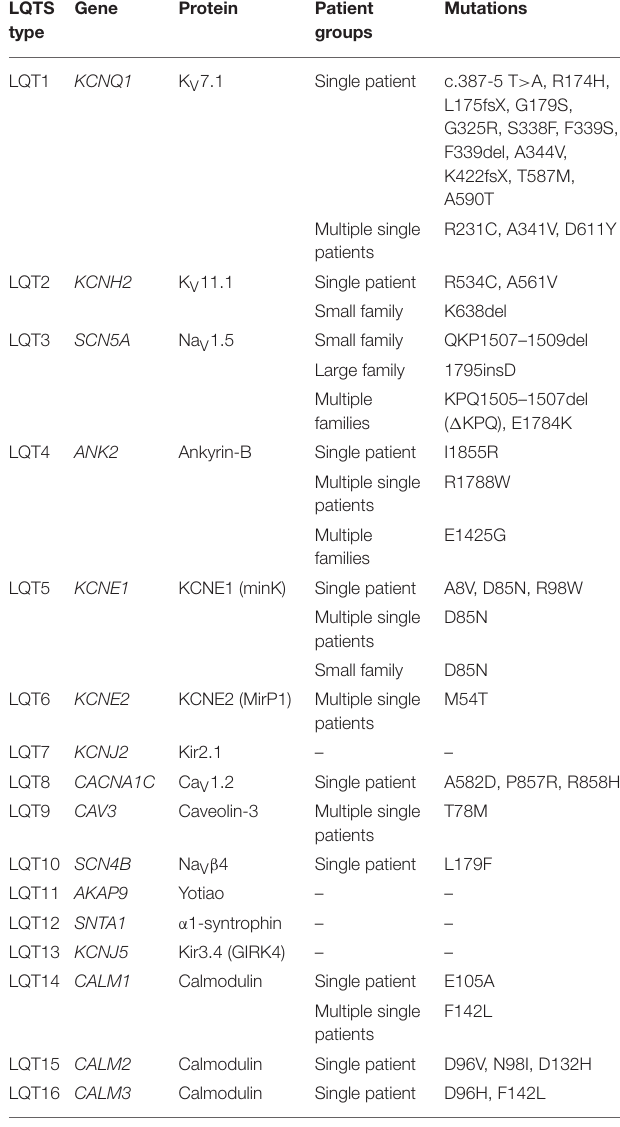
TABLE 1 | Mutations observed in patients with both sinus bradycardia and LQTS a